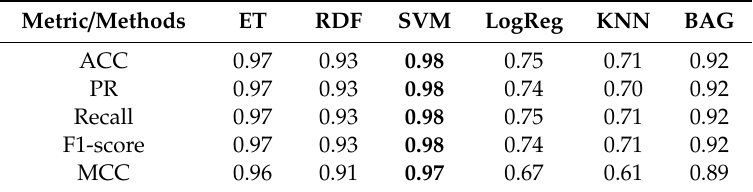
Table 3. Comparison of various machine learning algorithms on the CT scan dataset through the 10-fold cross-validation